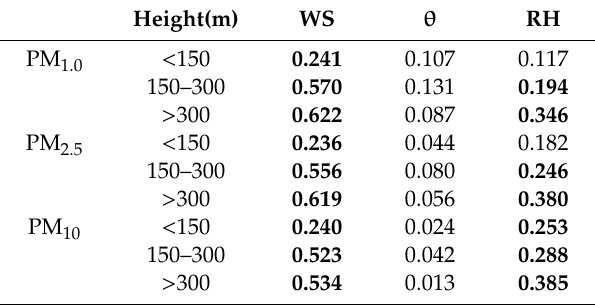
Figure 6. Vertical profiles of the pollutants ( a : PM 1.0 ; b : PM 2.5 ; c : PM 10 ) and related meteorological parameters ( d : Air temperature; e : Relative humidity; f : Wind speed) in the boundary layer above Tazhong during the observation periods. Table 3. Correlation coe ffi cients between the PM 1.0 , PM 2.5 , and PM 10 concentrations and the various meteorological elements at di ff erent heights above Tazhong (bold values represent those that passed the 95% significance